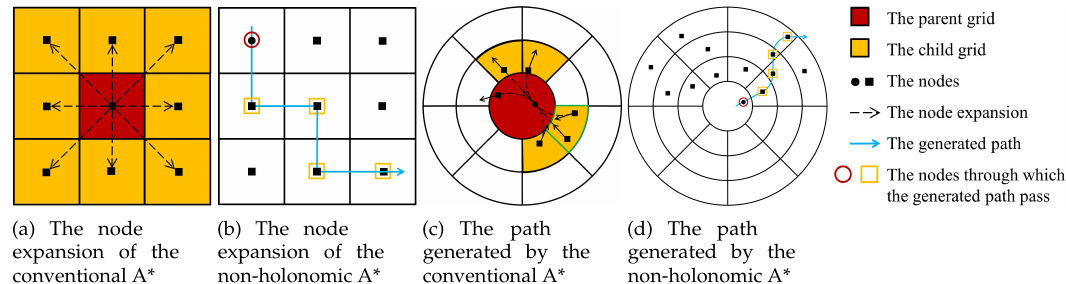
Figure 8. The differences between the conventional A* and the non-holonomic